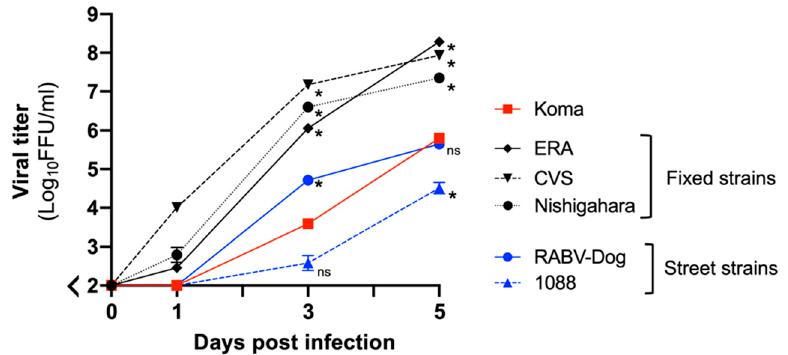
Figure 5. Growth curves for the Koma strain and representative street and fixed strains in mouse neuroblastoma C1300 (NA) cells. NA cells were inoculated with each of the virus strains at an MOI of 0.001. Viruses in the culture supernatants were collected at 0, 1, 3 and 5 dpi and titrated in NA cells by a focus assay. This assay was performed in triplicate, and the values in the graph are shown as means ± standard errors of the means. *, Significant differences vs. the Koma strain at a p value of < 0.05; ns, not significant ( p ≥ 0.05) .